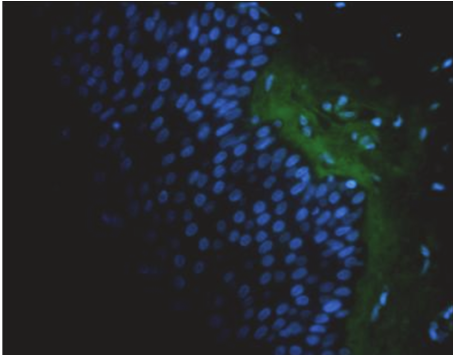
F 2: Histological examination: subcorneal pustule immedi- F3: Immuno�uorescence.Ig�-FITC���.e�gureshowsno antibody reactivity in epithelial cells and dermal-epithelial junction (basement